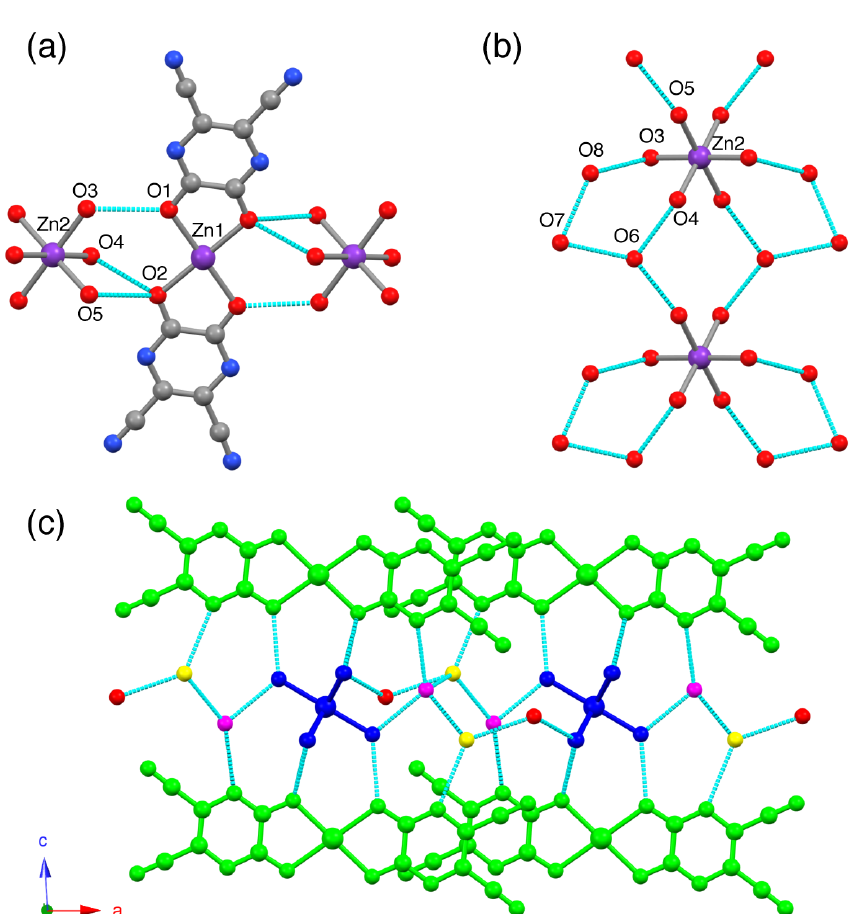
Figure 2. Crystal structure for 1 , highlighting hydrogen-bonding networks (broken cyan lines). ( a ) Hydrogen-bonding interactions between [Zn(CN 2 pyzdione) 2 (pyz)] 2– and [Zn(H 2 O) 6 ] 2+ units. ( b ) Hydrogen-bonding interactions between [Zn(H 2 O) 6 ] 2+ units and lattice H 2 O molecules, and between lattice H 2 O molecules. ( c ) View down of the b -axis, where green parts represent [Zn(CN 2 pyzdione) 2 (pyz)] 2– units, blue parts represent [Zn(H 2 O) 6 ] 2+ units, and magenta, red, and yellow balls represent O atoms of lattice H 2 O molecules, respectively. H atoms are omitted for clarity. Structure of 2 is composed also of polymeric 1D chains [Co(CN 2 pyzdione) 2 (pyz)] 2– , discrete [Co(H 2 O) 6 ] 2+ units and uncoordinated H 2 O molecules and the supramolecular structure is constructed by π -stacked layers of anionic [Co(CN 2 pyzdione) 2 (pyz)] 2– chains and the hydrogen-bonded layers of [Co(H 2 O) 6 ] 2+ units and interstitial H 2 O molecules (Figure S2, Supplementary Materials). In contrast to that of 1 , 2 crystallized in an achiral space group, C 2/ m and both Co1 and Co2 centers are located on the crystallographic two- fold rotation axis and mirror plane, consequently 2 exhibits a more symmetric structure than that of 1 . While 1 has long and short Zn1–N5 and Zn1–N6 bond distances, which alternatively aligned in the 1D chain, the Co1–N5 distances are symmetry-related and, thus, they are equivalent in 2 . Reflecting the crystallographic symmetry between 1 and 2 , the discrete [Co(H 2 O) 6 ] 2+ unit also shows more symmetric structure with two Co2–O3 and Co2–O4 bond distances of 2.063(2) Å and 2.0915(16) Å (vide supra, there are three hydrogen bonds in 1 . On the other hand, the two H 2 O molecules are symmetry-related so that the hydrogen bond distances are equal in 2 , which also contains interstitial H 2 O molecules similar to that of 1 . However, the interstitial H 2 O molecules (O6 and O7) are disordered over two symmetry-related sites with 50% occupation to yield symmetric hydrogen-bonding interactions with nitrogen atoms of 1D chain. In contrast to the